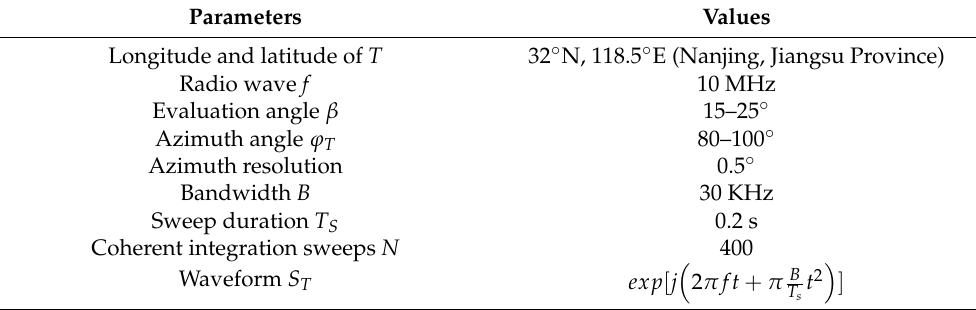
Table 1. SWR parameters. Parameters Values Longitude and latitude of